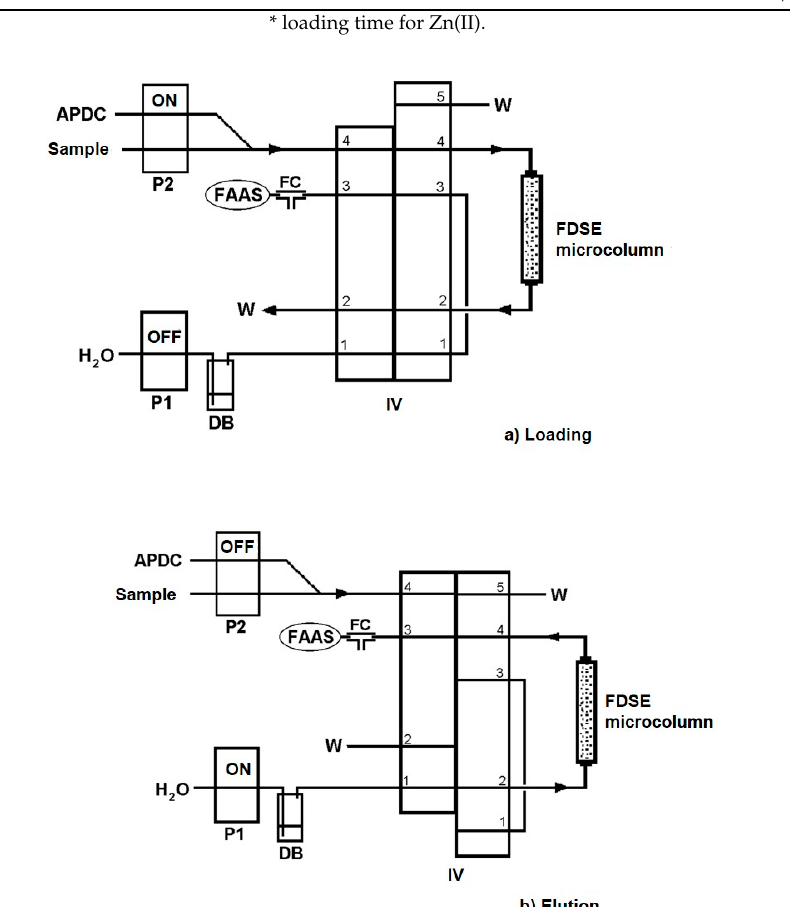
Figure 1. Schematic diagram of the on-line FI-FDSE system for metal determination by FAAS. ( a ) Loading/preconcentration and ( b ) Elution/measurement steps. APDC, 0.05% ( m / v ) APDC aqueous solution; FC, flow compensation unit; P1, P2, peristaltic pumps; IV, injection valve; DB, displacement bottle for MIBK delivery; W, waste.